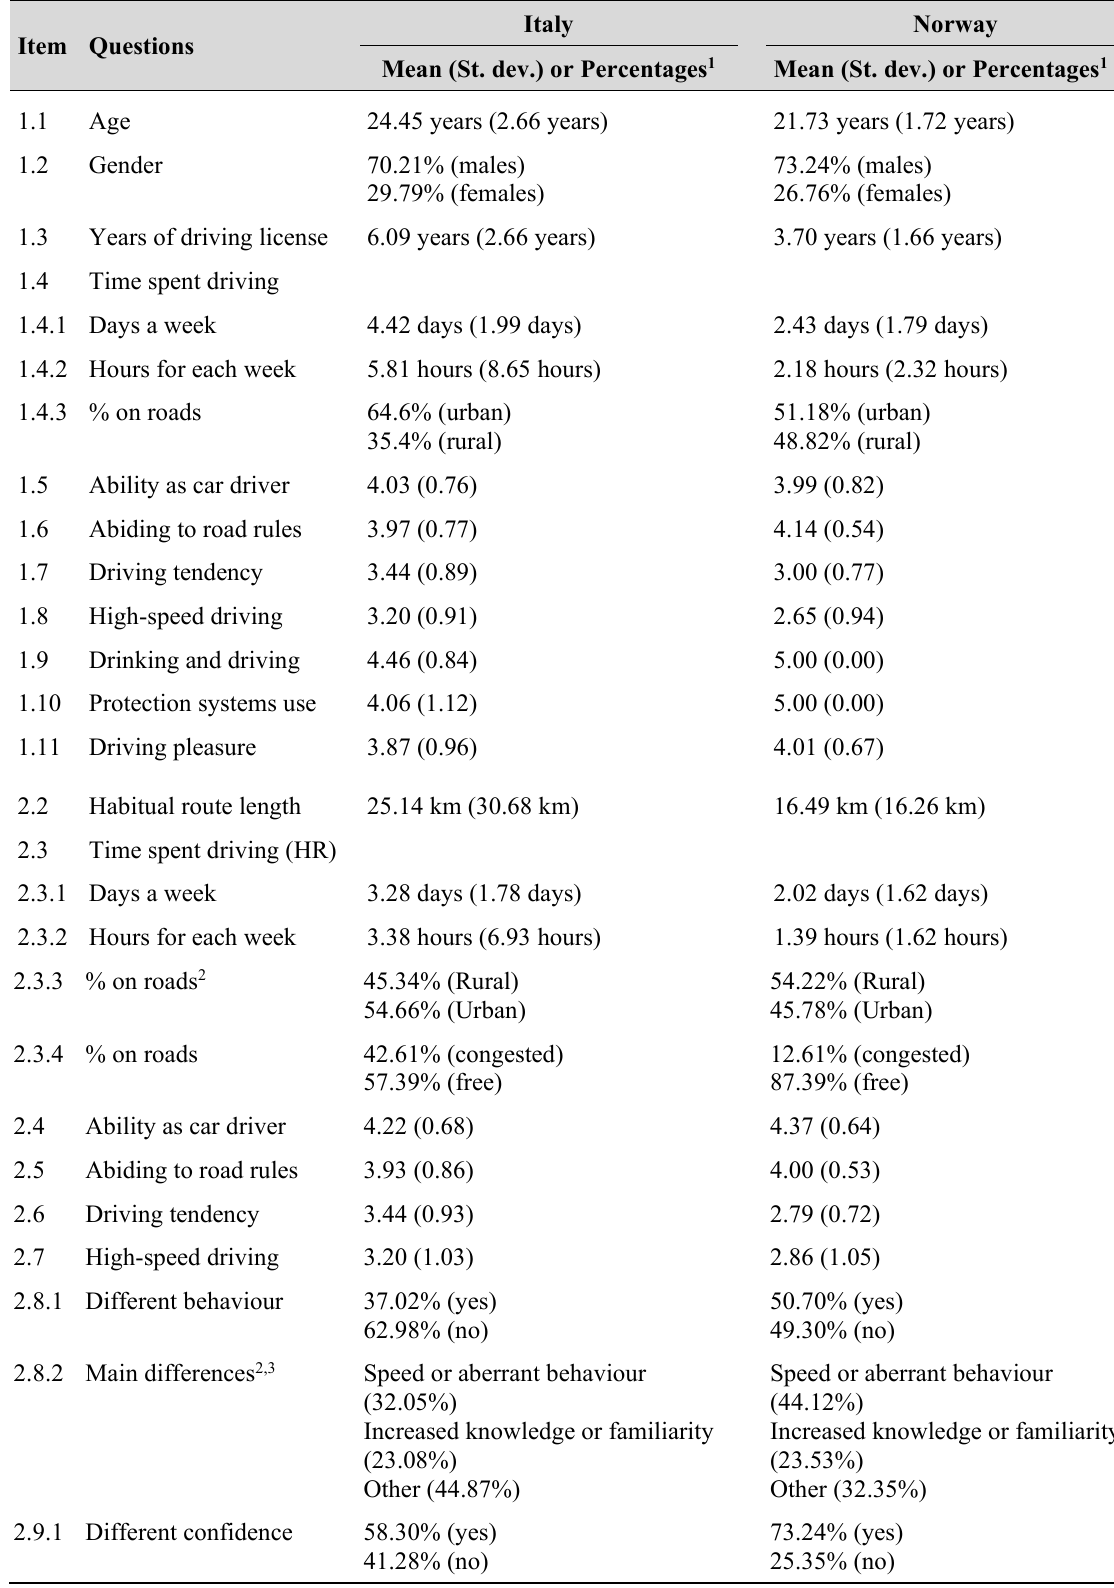
Table 2 Descriptive statistics of results from surveys (related to the samples of data after cleaning proce- dures: N Italy = 235, N Norway =